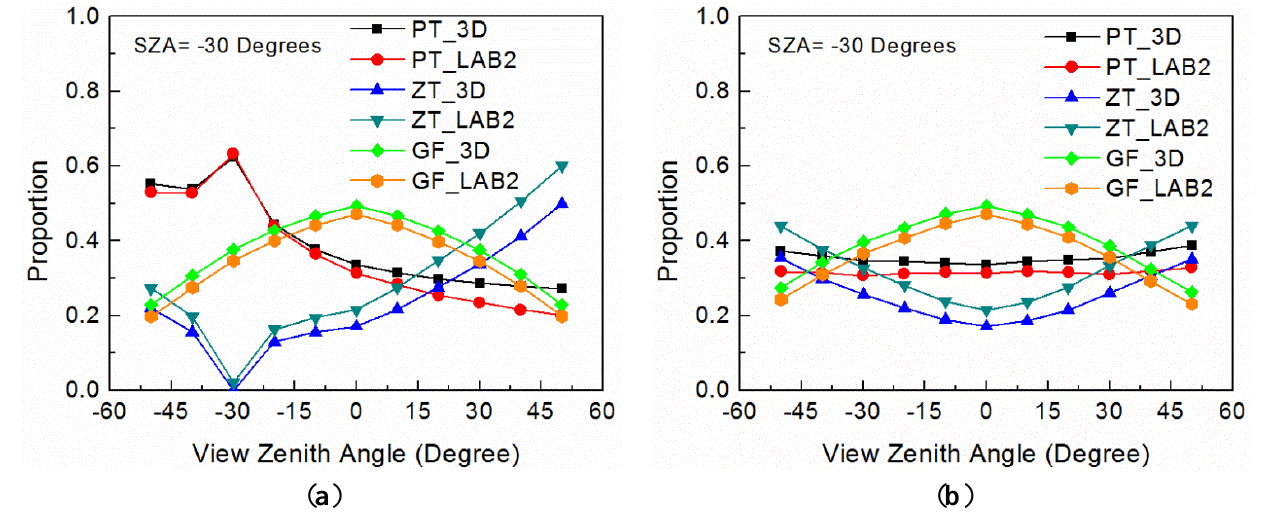
Figure 6. The area ratio of the sunlit foliage component ( P T ), shaded foliage component ( Z T ) and gap fraction (GF) extracted by the LAB2 algorithm and the 3D reference values in the principal plane ( a ) and in the cross plane ( b ) with the solar zenith angle (SZA) of −30°